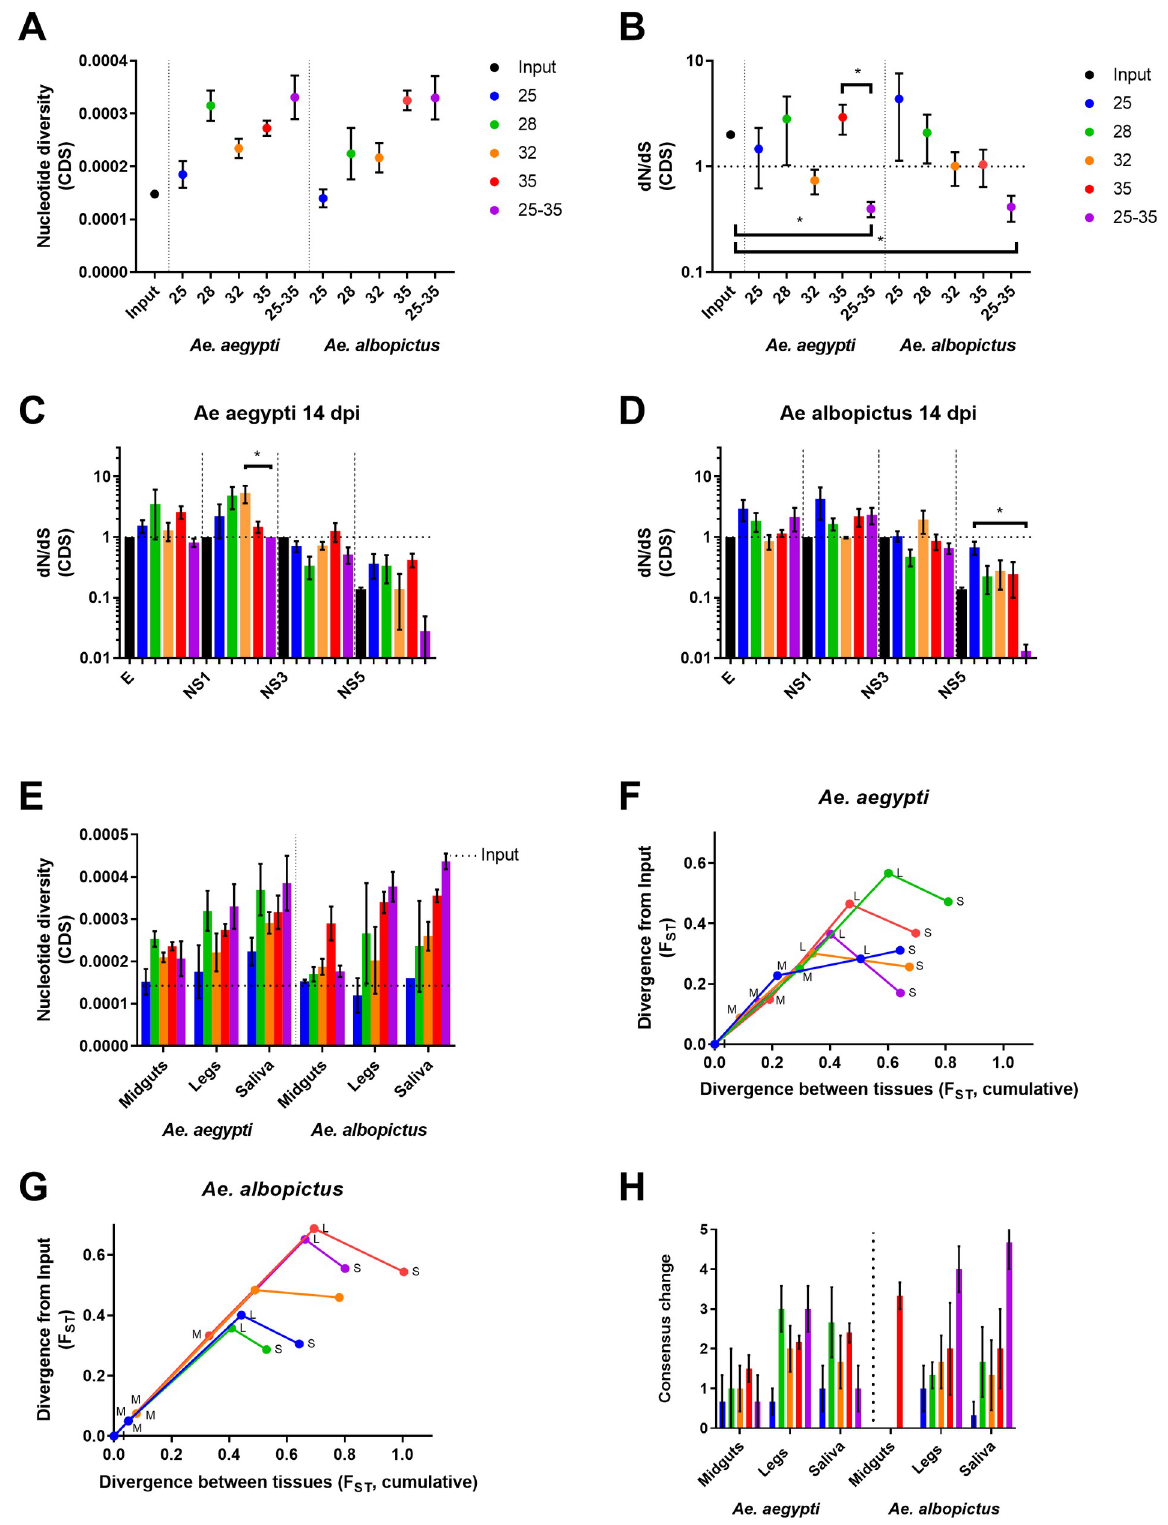
Fig 2. Extrinsic incubation temperature alters virus diversification, selection and divergence during mosquito infection. ZIKV population diversity at varying EITs was determined using measures of nucleotide diversity (A) and natural selection (d